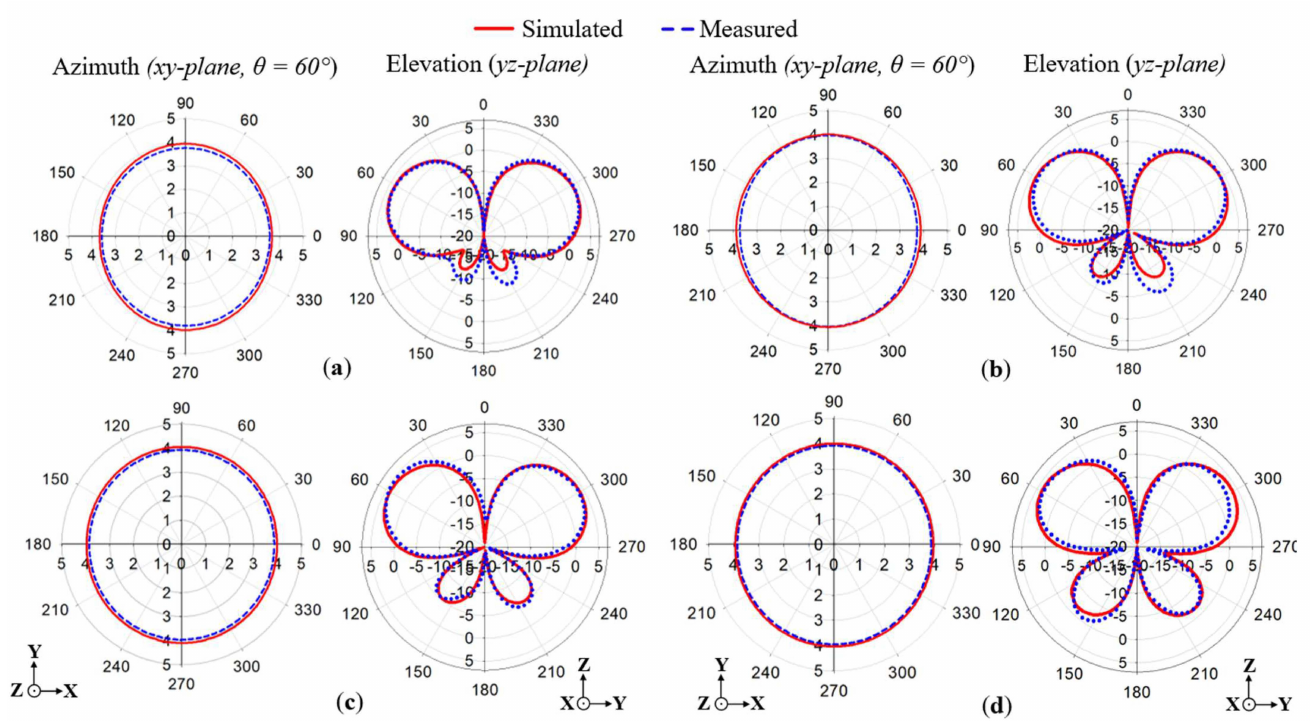
Figure 13. Simulated and measured results of the azimuth and elevation radiation patterns for ( a ) 1.7 GHz, ( b ) 1.8 GHz, ( c ) 1.86 GHz, and ( d ) 2 GHz. The simulated and measured |S 11 |results of the proposed antenna are shown in Figure 14. It can be observed that the simulated results agree well with the measured ones. However, the slight discrepancy between the measured and simulated results at the frequency points of 1.8, 3.3, and 3.8 GHz is due to the imperfect contact of the cross- ground plane with the circular-disk plane during fabrication. Regardless, both the simu- lated and measured results verify that the antenna offers a wide impedance bandwidth (|S 11 | < − 10 dB) of 83.2% ranging from 1.65 to 4 GHz.